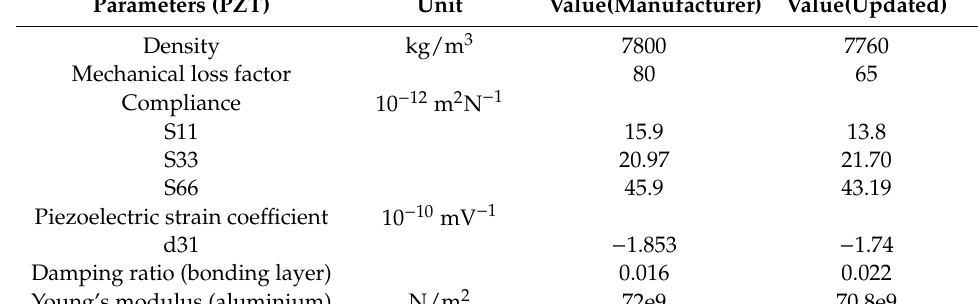
Table 3. Modified parameters of piezoelectric material in finite element modelling.